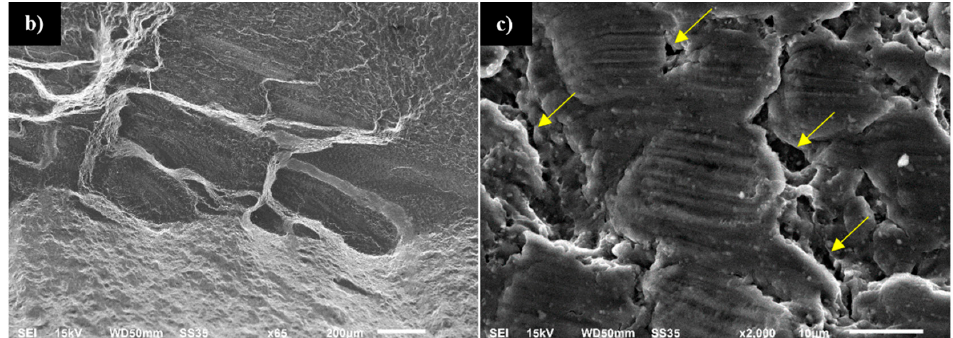
Figure 17. SEM images of fatigue surfaces of a specimen tested at a strain amplitude of 0.5%: ( a ) overall view of the fracture surface, ( b ) bottom part of the fracture surface, and ( c ) fatigue striations. The yellow arrows indicate the secondary cracks.